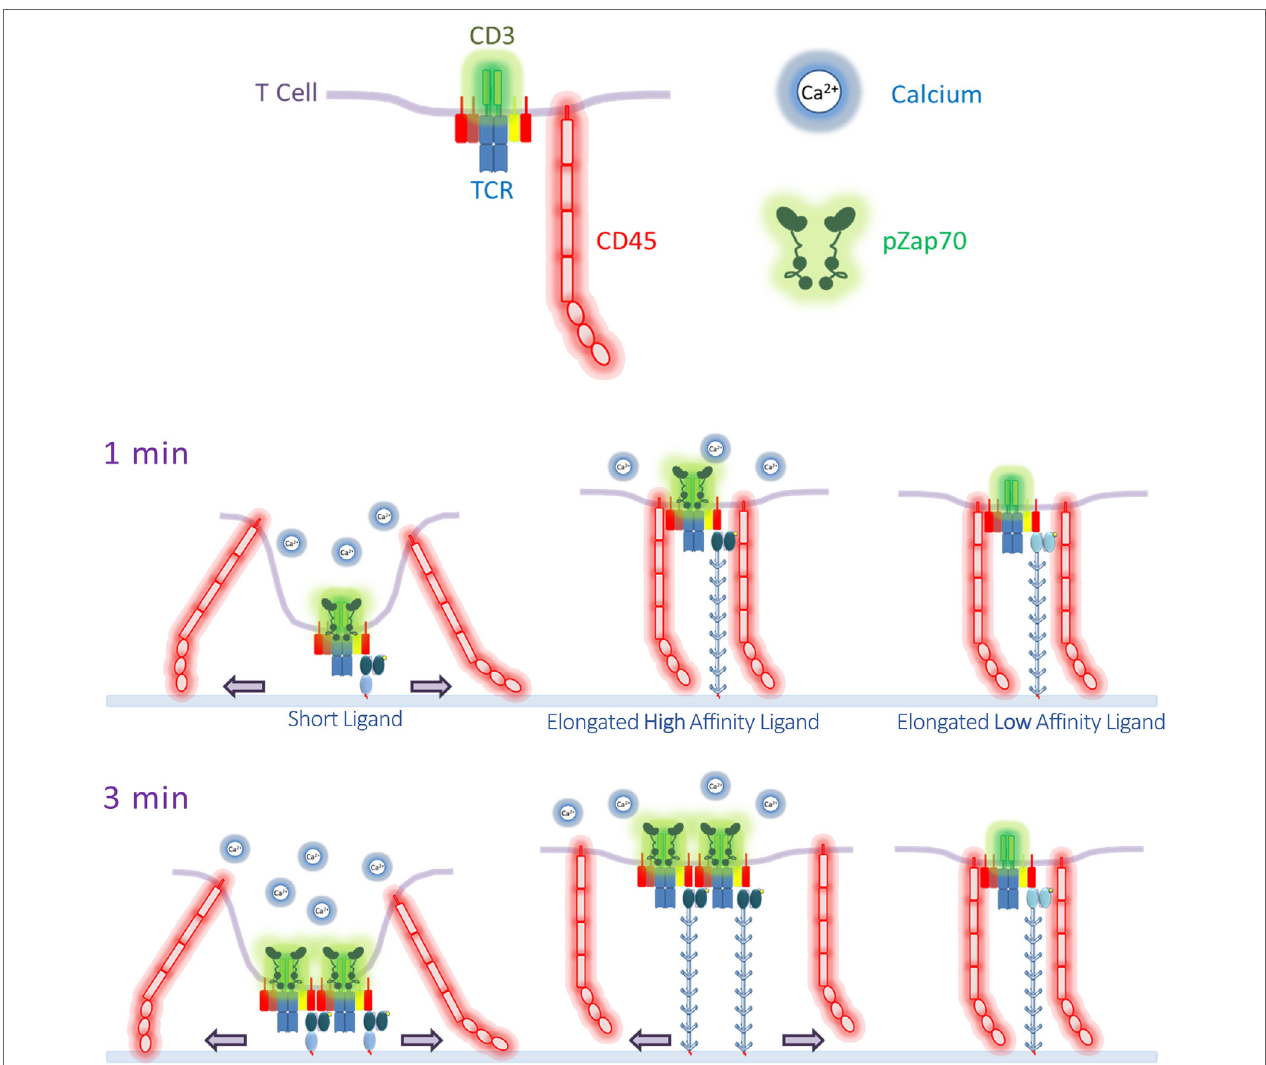
FigUre 10 | Summary of T cell receptor (TCR) triggering by anti-CD3 scFv ligands. After 1 min of T cell contact to the lipid bilayers decorated with the ligands, short ligands efficiently and completely segregate CD45 from TCRs, accompanied with calcium mobilization. On the other hand, CD45 is co-localized with TCR in cells triggered with elongated ligands, but only a high-affinity elongated ligand was able to induce calcium mobilization to similar levels as the short ligand. However, an elongated low-affinity ligand did not show any segregation of CD45 from TCR, and failed to induce calcium flux. After 3 min, CD45 started to segregate partially from TCR microclusters engaged by an elongated high-affinity ligand but not the low-affinity ligand. pZap70 was also detected in T cells incubated on lipid bilayers decorated with short ligands and elongated high-affinity